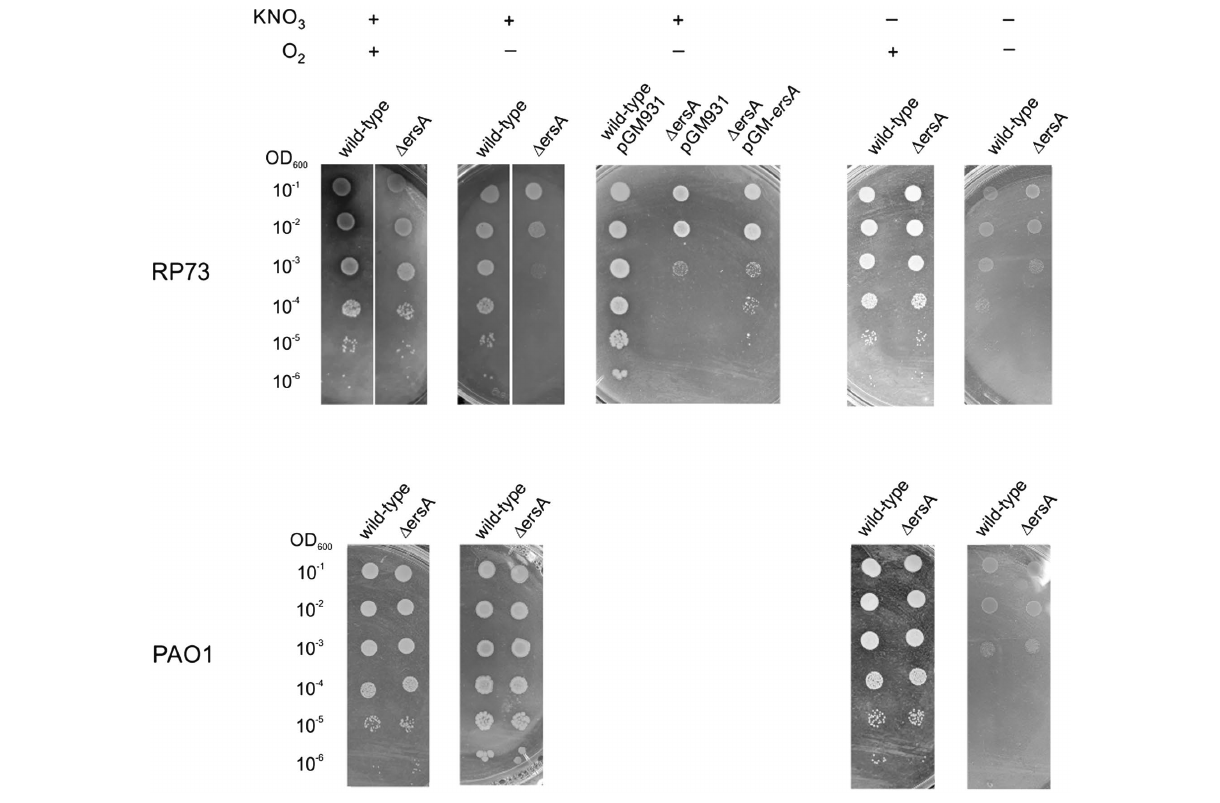
FIGURE 3 | ErsA deletion impairs anaerobic growth in the RP73 clinical isolate. 2 μ l of cultures of the wild-type P. aeruginosa clinical isolate RP73 and PAO1 along with the corresponding ∆ ersA mutants, serially diluted 10-fold, were spotted into BHI agar plates supplemented with 100 mm KNO 3 to allow anaerobic respiration or without KNO 3 addition to assess arginine fermentation capacity. Plates were incubated under aerobic (+O 2 ) or anaerobic ( − O 2 ) conditions. The presented results are representative of three independent